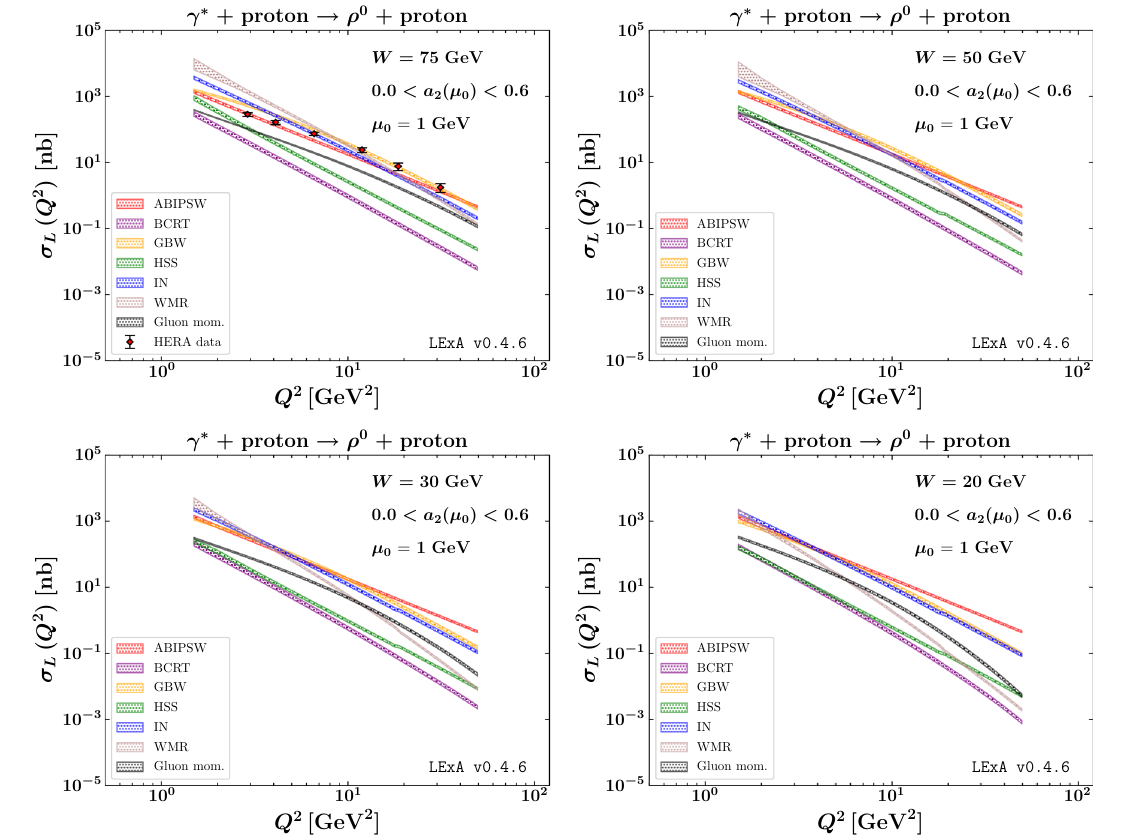
Fig. 3 Q 2 -dependence of the longitudinally polarized cross section, (the remaining panels). Uncertainty bands represent the effect of vary- σ = 75 GeV together with ing a 2 (μ 0 = 1 GeV) between 0 . 0 and 0 . L , for all the considered UGD models, at W the HERA data (left upper panel) and at W = 20 , 30 , 50 GeV for EIC